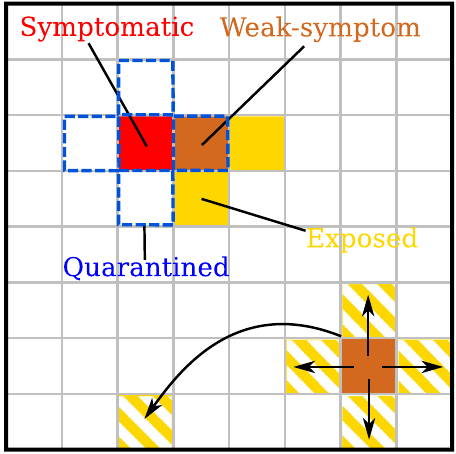
Fig. 1 Spatial epidemic model with testing and quarantining. The base model is illustrated on a square grid. Every day each infectious individual (agents are represented here as a tile on a lattice) interacts with their neighbors and with a randomly selected individual, and transmits the disease (arrows in fi gure) with constant probability if the individuals they interact with are susceptible. The tiles with yellow and white stripes denote the potential contacts that can be exposed. Upon identi fi cation of a positive case (red tile) all the neighbors are put into quarantine and tested (blue dashed border). Weak-symptom cases (brown tile with blue dashed border) can only be identi fi ed if they are neighbors of a known positive